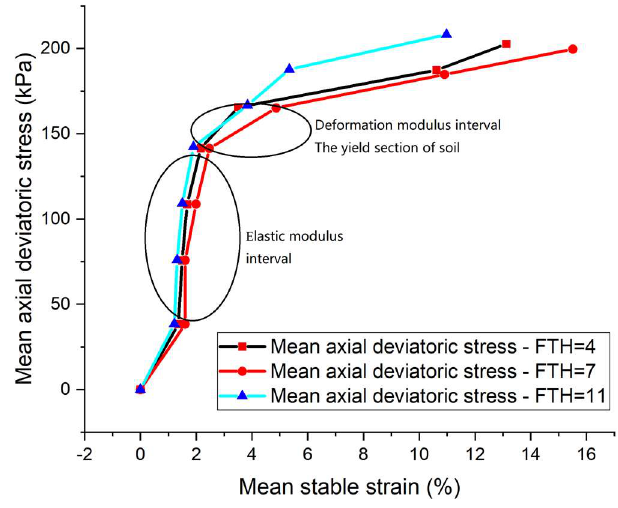
Figure 30. Mean axial deviatoric stress–mean stable strain under different FTHs.